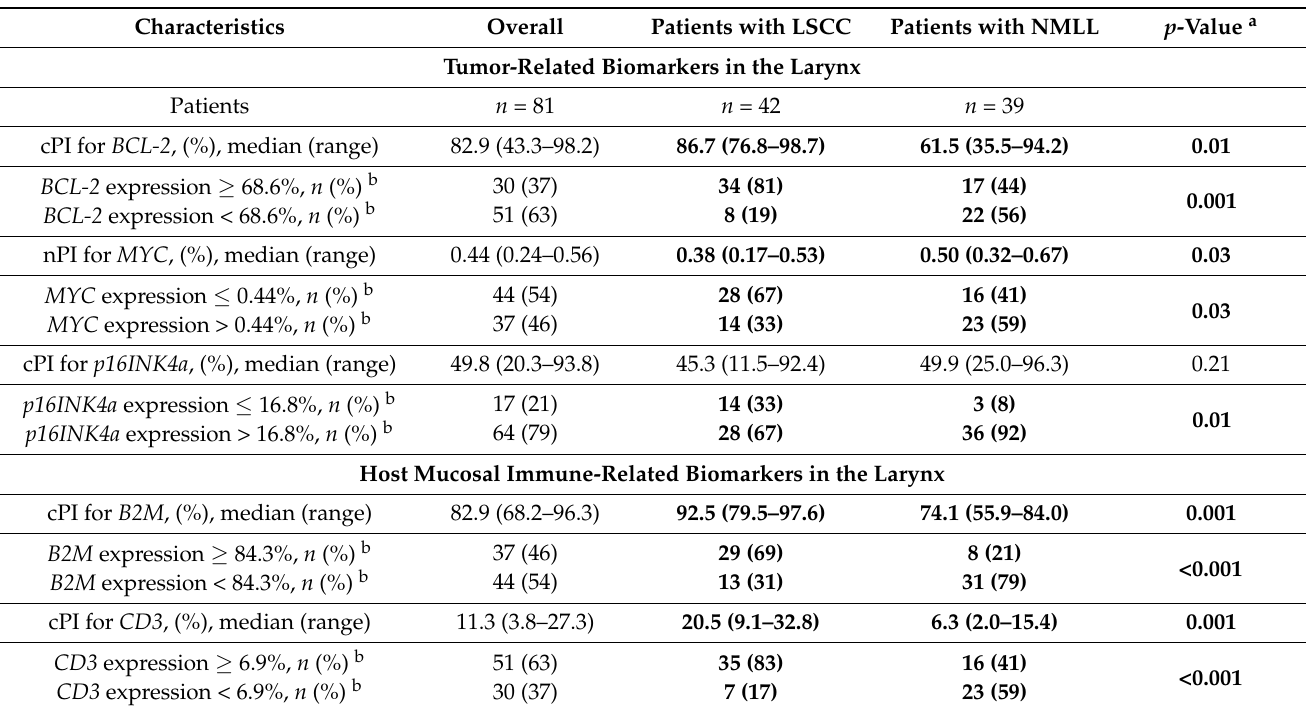
Table 3. Histological factors of the